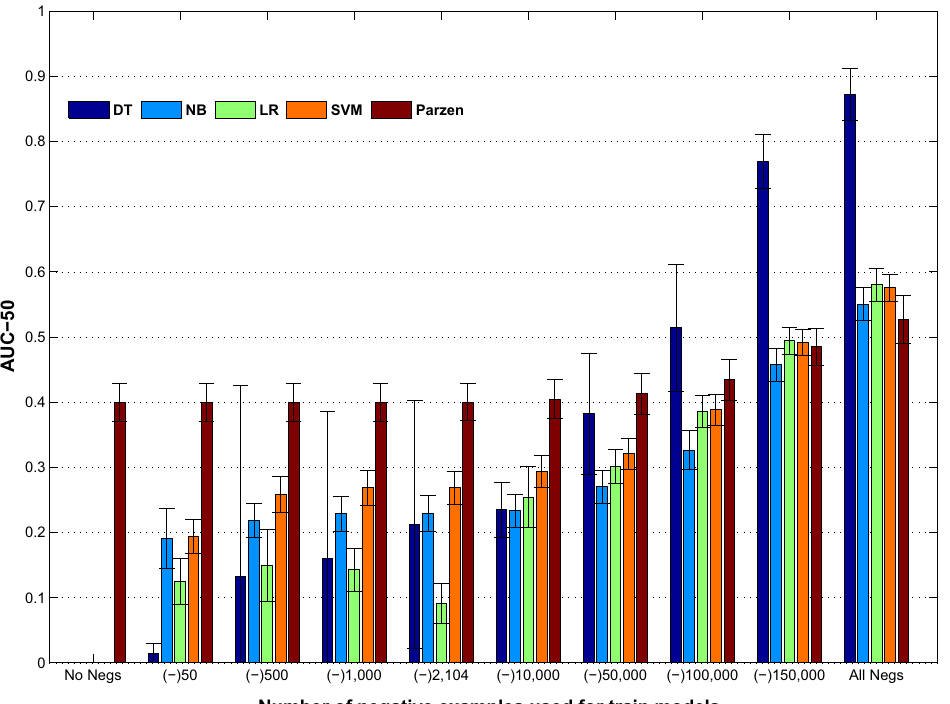
Figure 2: AUC-50 comparison for different learning methods evaluated, showing the effect of re- ducing and incrementing the number of negative examples used to train the models. The balanced class scenario is when 2,104 negative examples are used for training. Note that no corrective action was taken for any of the imbalanced class